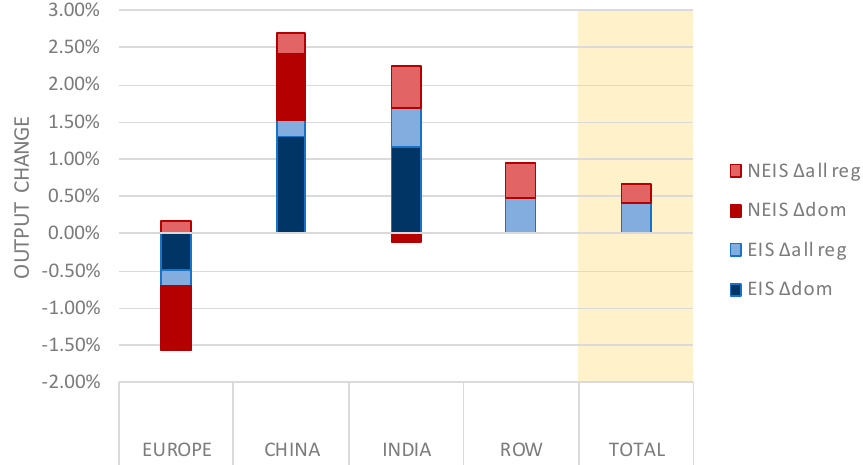
Figure 7. Effects on total output (EIS = energy intensive sectors; and NEIS = non-energy intensive sectors) by region (ROW = rest of the world) in 2030 for low carbon technology scenario relative to baseline; decomposition into effects of domestic technology investment ( Δ dom ) and technology investment in all regions ( Δ all ).